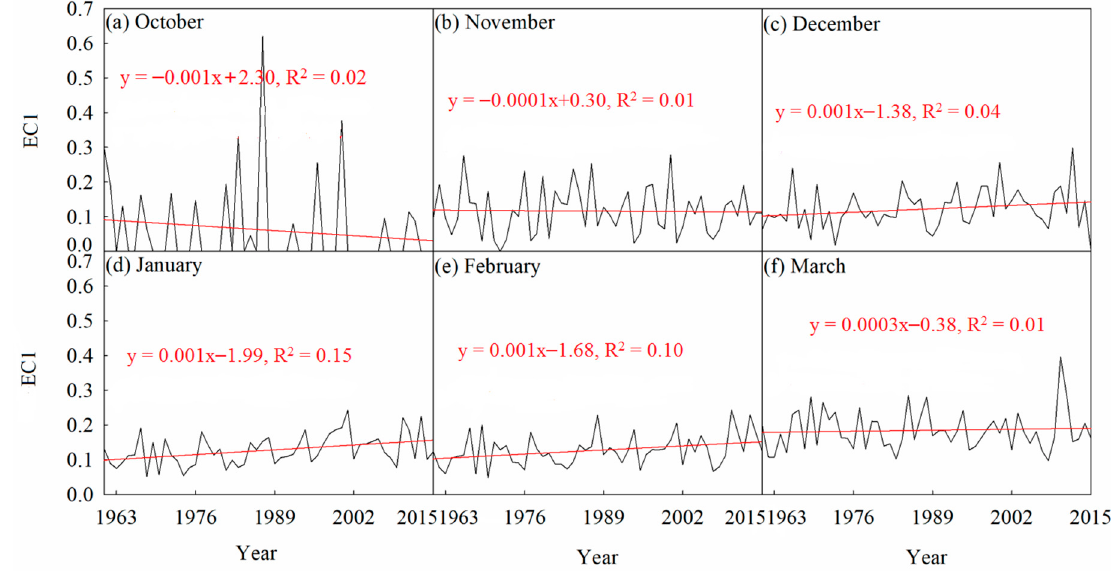
Figure 5. The variations of monthly EOF first time mode (EC1) in Xinjiang: ( a ) October, ( b ) November, ( c ) December, ( d ) January, ( e ) February and ( f ) March.